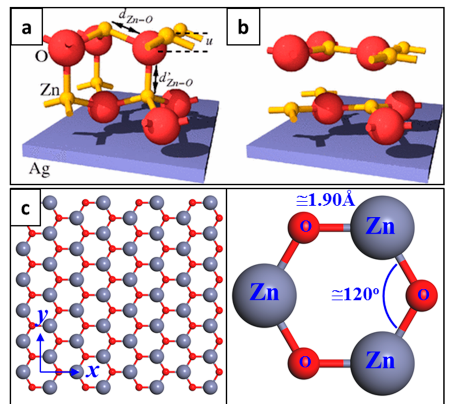
Figure 1. Lattice structure of graphene-like ZnO. ( a ) ZnO bi-layer wurtzite structure over Ag(111). ( b ) Bi-layer graphene-like ZnO structure (transformed from wurtzite structure). Reprinted with permission from Reference [4]. Copyright © (2007) American Physical Society. ( c ): Graphene-like ZnO geometry of a conventional g-ZnO cell.